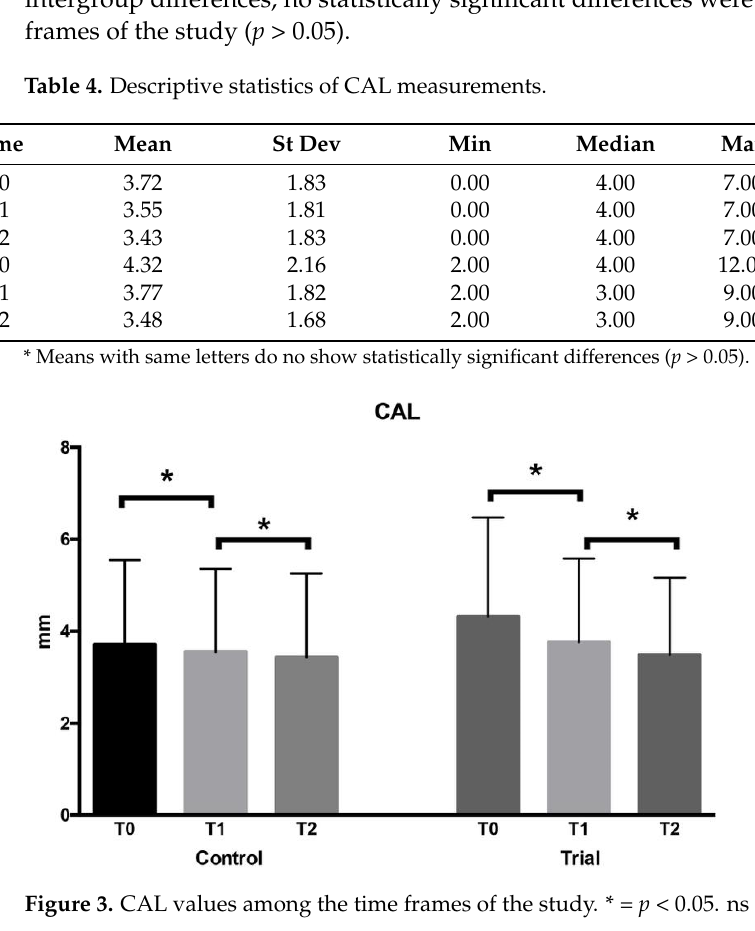
Figure 2. GE values among the time frames of the study. * = p < 0.05. ns = not significant.